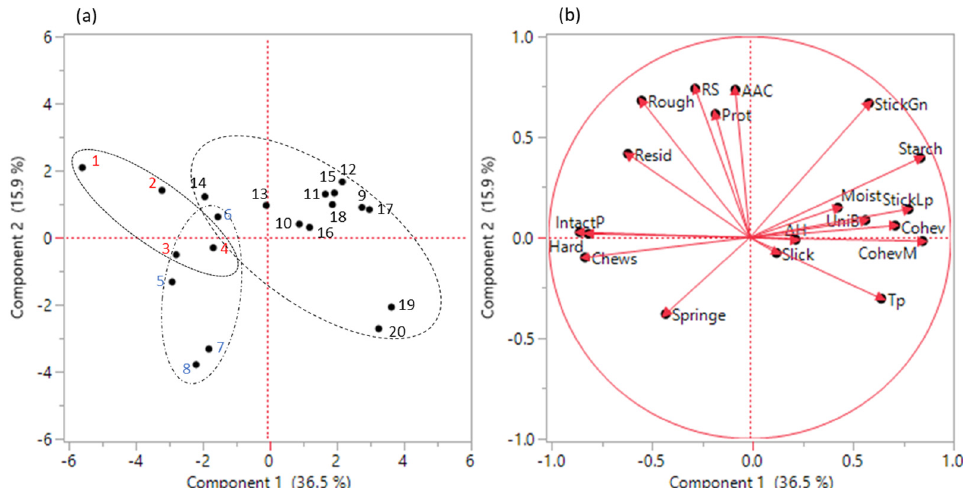
Figure 3. The score plot ( a ) and loading plot (B) of PCA analysis of grain quality traits and texture attributes of 10 high AAC varieties grown in LA and AR. In ( a ), the numbers in red font (No. 1–4) are varieties in the T-TT haplotype, blue font (No. 5–8) the T-GC haplotype, and black font (No. 9–20) the C-GC haplotype. For variety names and growing states for these numbers, refer to Table 1. In ( b ), for trait abbreviations see Tables 2 and S1.